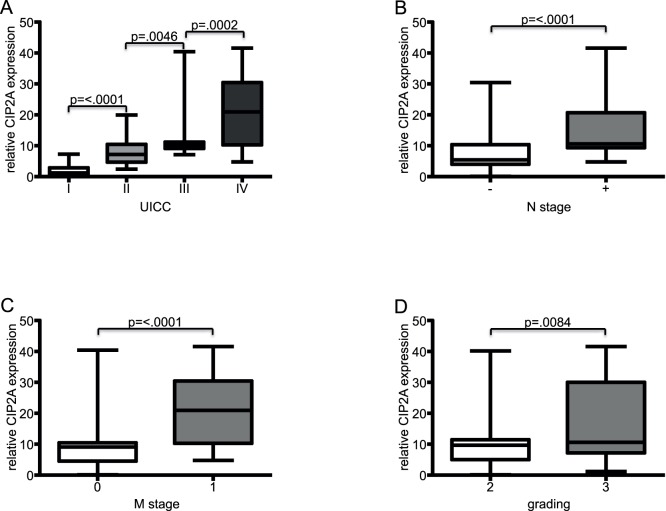

CIP2A mRNA expression is significantly correlated with advanced tumour stage.The panels show box and whisker plots documenting relative CIP2A mRNA levels in tumors stratified according to UICC stage (A) (UICC I vs. II p<.0001; II vs. III p = .0046; III vs. IV p = .0002), according to lymph node metastasis (B; N- vs. N+ p<.0001), according to distant metastasis (C; M0 vs. M1 p<.0001), and according to histological grading (D: G2 vs. G3 p = .0084).